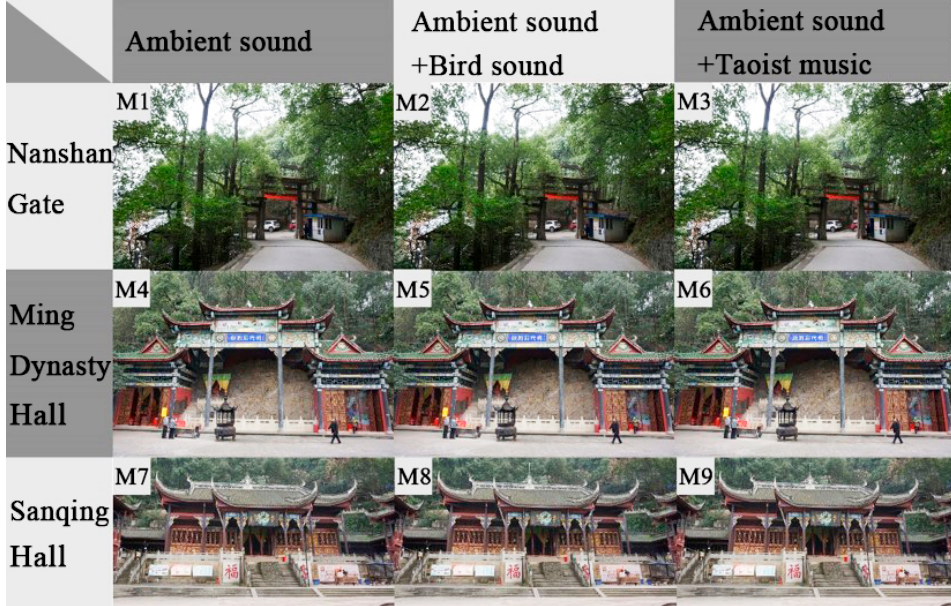
Figure 5. 9 combinations (M1–M9) of three visual materials and sounds representing the typical characteristics of landscape and soundscape in Laojundong